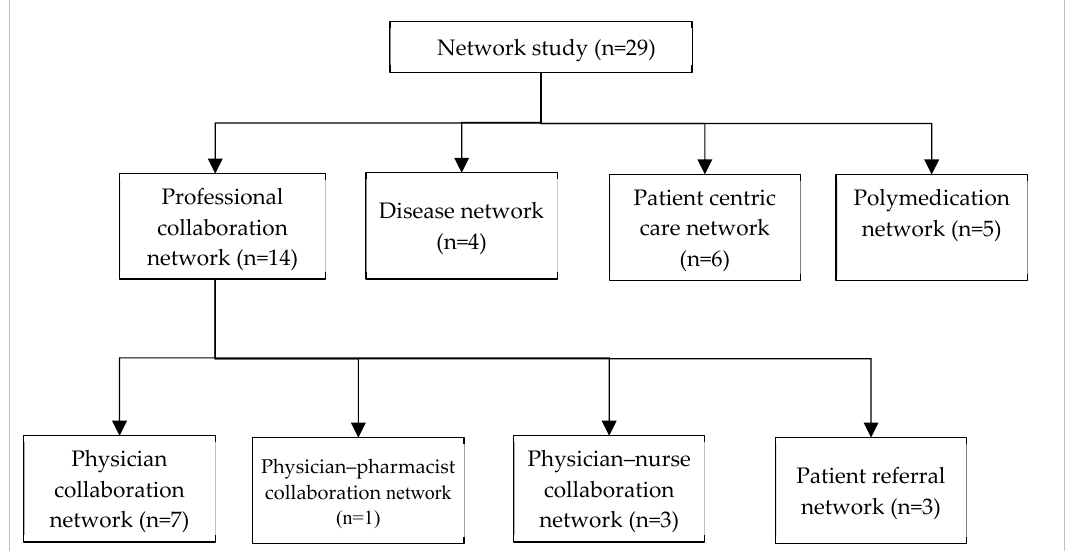
Figure 2. The list and number of various types of network studies (based on administrative health data) that were reviewed in this study.